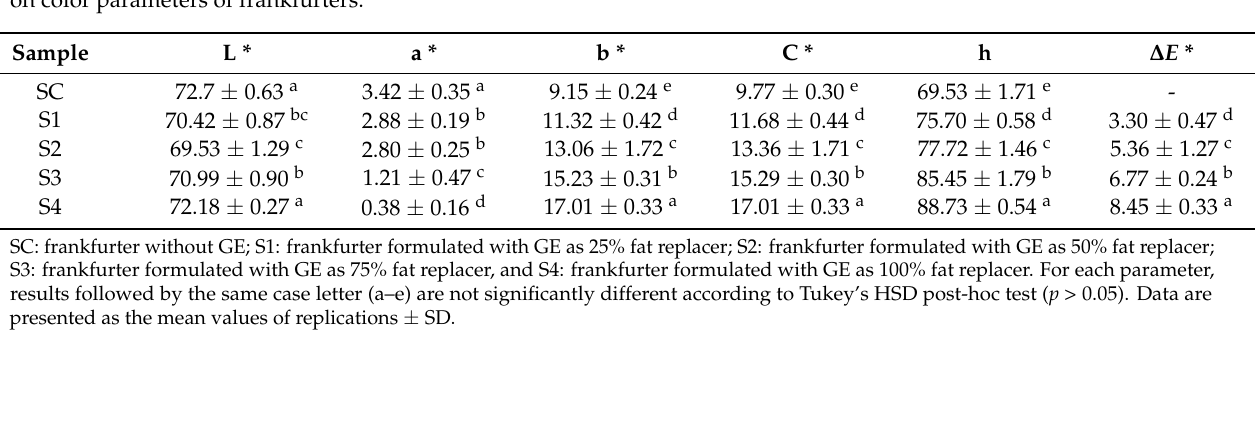
Table 4. Effect of partial and total replacement of pork back fat by the gelled emulsion from hemp oil and buckwheat flour on color parameters of